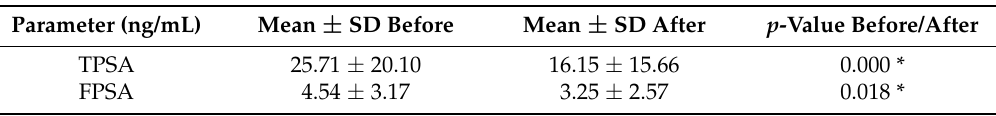
Table 1. Parameters relating total PSA (TPSA) and free PSA (FPSA) shown as mean values before and after treatment.